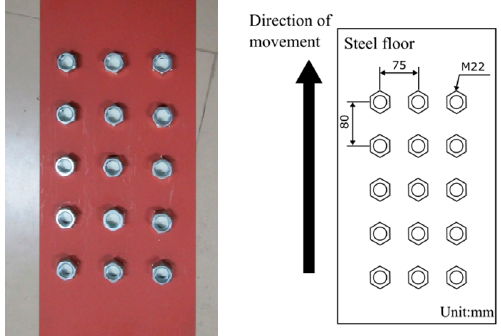
Figure 13. Model of the splicing part with 15 nuts for the experiment.